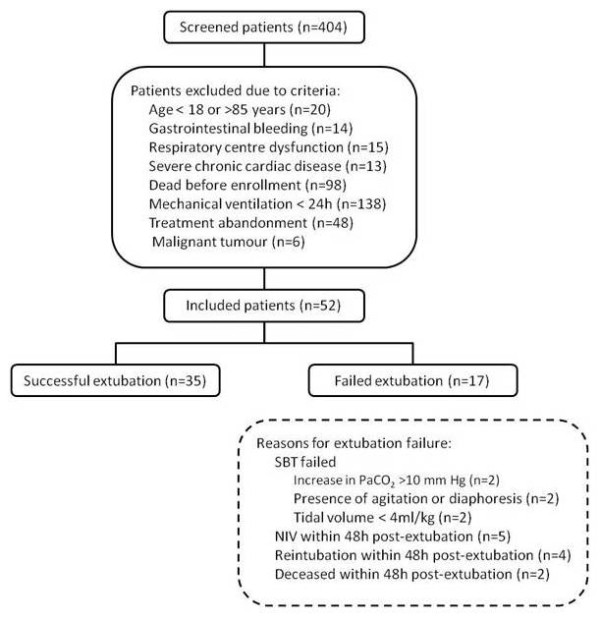
Flow chart of the study.